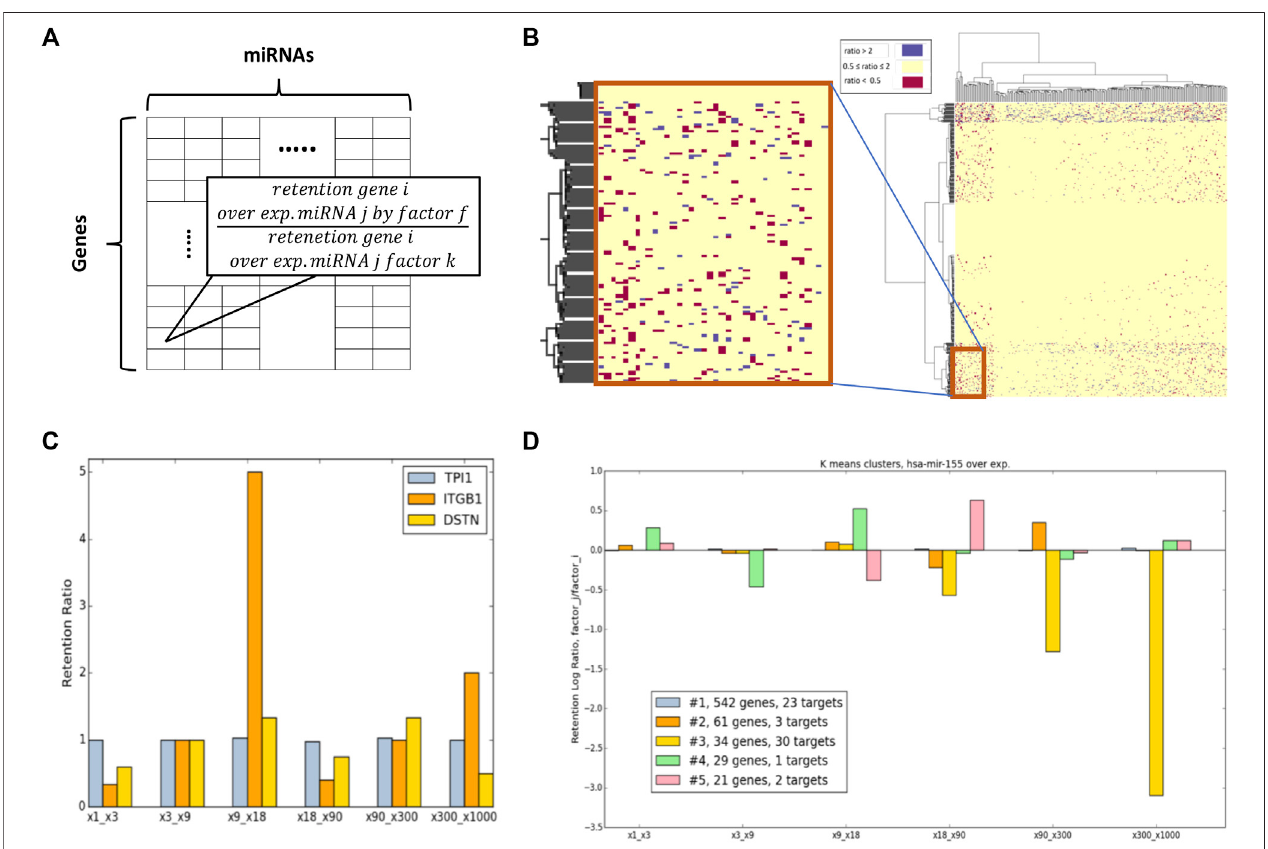
FIGURE 6 | Overexpression ratio (OXR) classes. (A) Scheme for the presented M fi j/Mkij ratio retention matrix. (B) Ratio matrix for x90/x9 and a zoon-in for a small section. Colors only marked genes that show a signi fi cant ratio difference (by the predetermined differential folds of > 2, and < 0.5). (C) Examples of 3 selected genes according to the retention ratio from the 6-consecutive ratio-matrices. (D) A case study of hsa-mir-155 manipulation via OXR-clusters. A measure of the genes associatedwith fi veOXR-classesrepresentedfor6-consecutive ratiomatrices (x-axis). Thenumbers ofexpressed targetsofhsa-mir-155 thatareincluded ineach OXR-class (including the numbers of direct targets) are